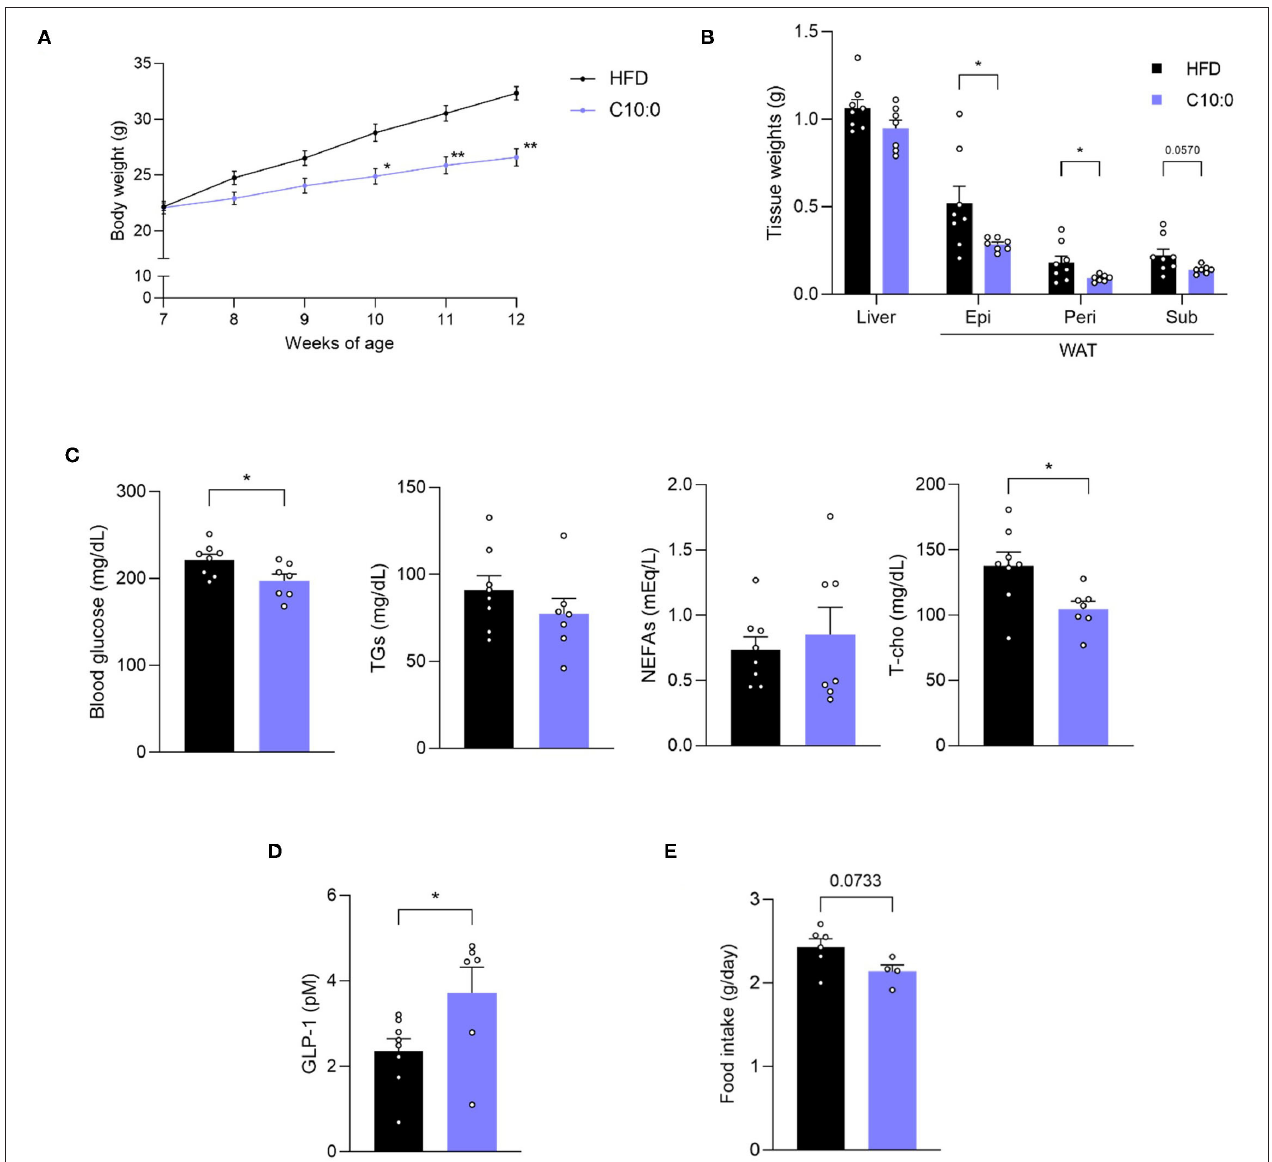
FIGURE 6 | Decanoate (C10:0) intake improves metabolic functions in high-fat diet (HFD)-induced obese model mice. (A) Body weight gain for 5 weeks in HFD- or C10:0-supplemented HFD-fed mice (n = 8, 7) and (B) tissue weight in HFD- or C10:0-supplemented HFD-fed mice at 12 weeks of age (n = 8, 7). (C) Blood glucose, plasma triglycerides (TGs), non-esterified fatty acids (NEFAs), and total cholesterol (T-cho) levels in HFD- or C10:0-supplemented HFD-fed mice at 12 weeks of age (n = 8, 7), (D) plasma GLP-1 levels (n = 8, 6) in HFD- or C10-supplemented HFD-fed mice at 12 weeks of age were measured after fasting for 5h. (E) Daily food intake measured at 7 weeks of age (n = 6, 4) **P < 0.01, *P < 0.05 ( A , Tukey-Kramer test, B – E , Student’s t test). All data are presented as the means ± standard error of mean (SEM). C10:0, 5% decanoate (C10:0)-supplemented HFD. Epi, epididymal adipose tissues; peri, perirenal adipose tissues; sub, subcutaneous adipose tissues; WAT, white adipose